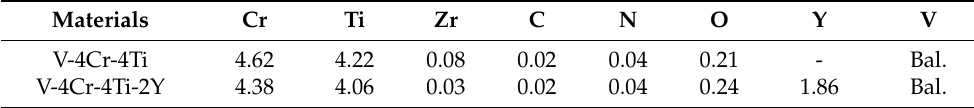
Table 1. Chemical composition of two kinds of V alloy (wt.%).